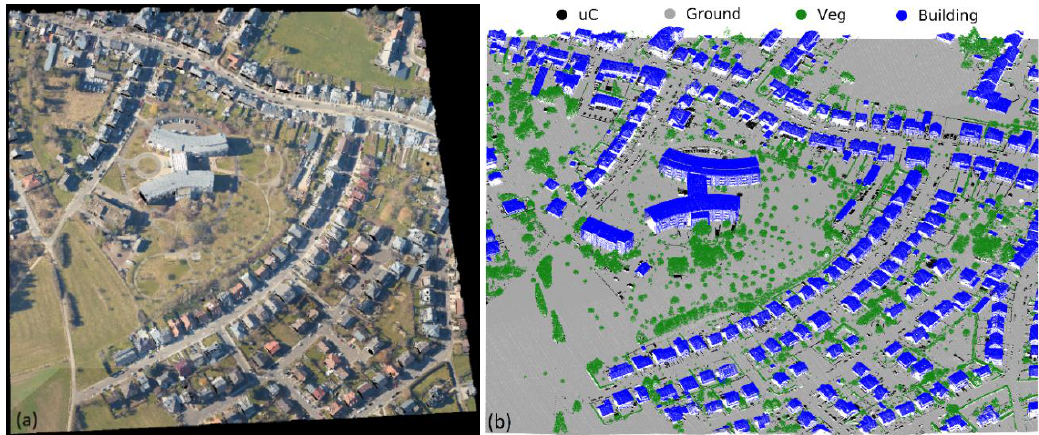
Figure 6. (a) Dudelange test dataset in an urban area contains large-medium-small trees, large-small commercial and residential buildings, car, etc., (b) test dataset with ground-truth point labels.